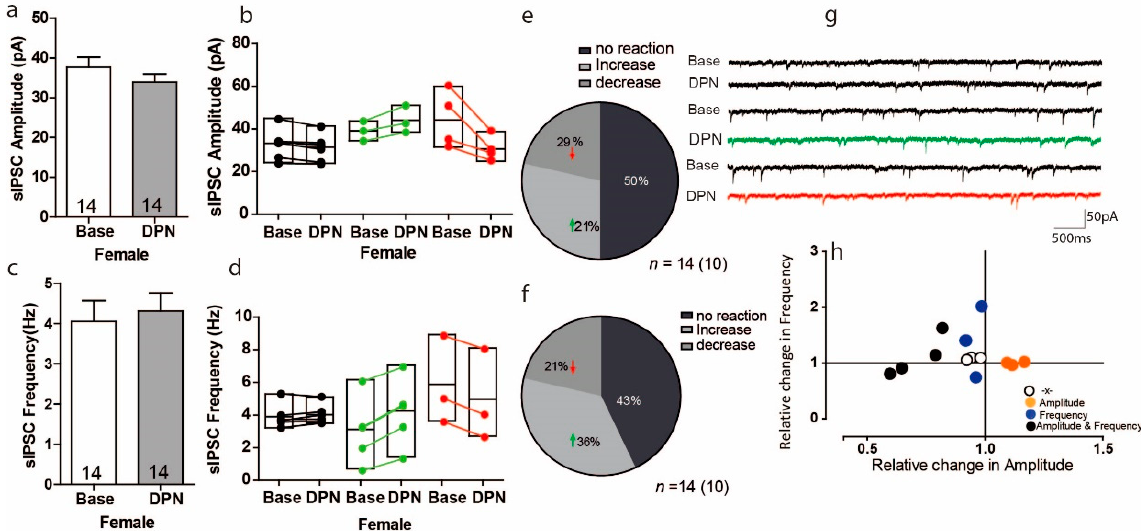
Table 1. Kinetics of spontan GABAergic currents in Base and after application of DPN in females.